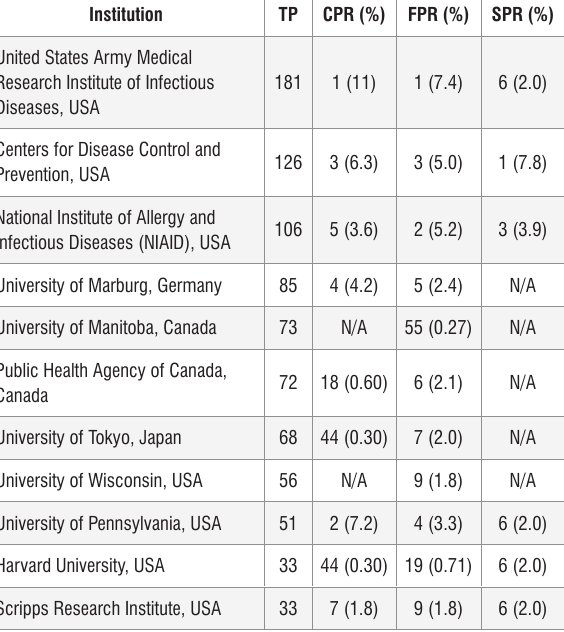
(e.g. ‘A case of Ebola virus-infection’ 24 and ‘Ebola virus: Comparison,